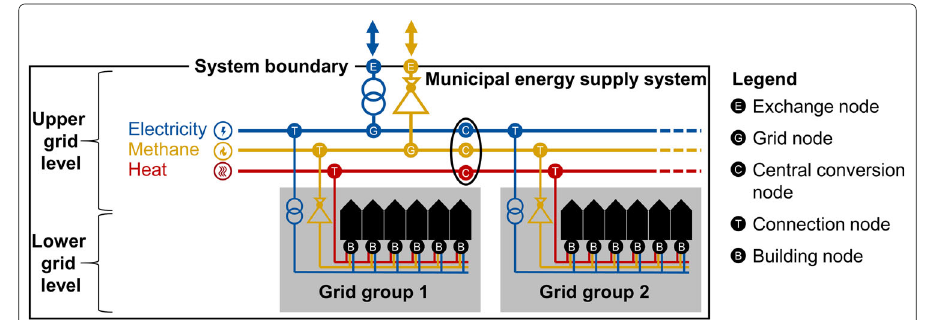
Fig. 1 The grid model contains individual nodes and edges for the energy carriers electricity, heat, and gas. ‘Building nodes’ and ‘central conversion nodes’ span across all energy carriers and connect these. The grid of each energy carrier consists of the ‘upper’ and ‘lower’ grid level connected at ‘connection nodes’